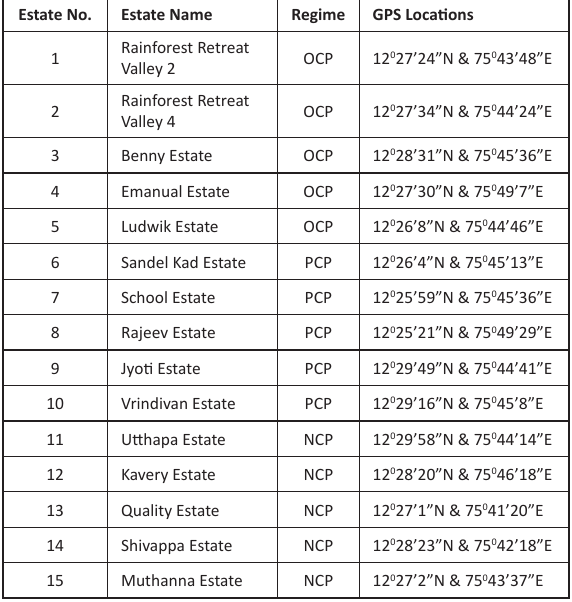
Table 1. GPS locations and regimes of the 15 coffee plantation sites.